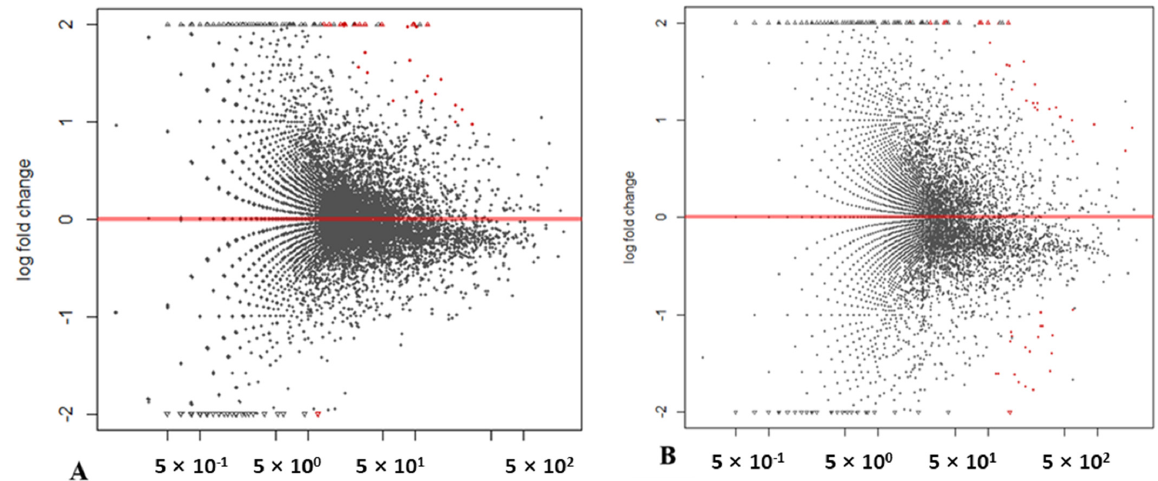
Figure 2. MA-plot from base means ( x -axis; ‘M’) and the average of log fold changes ( y -axis; ‘A’), indicating differentially expressed genes in pea resistant (R) or susceptible (S) to Aphanomyces root rot in DESeq analyses of ( A ) an in silico mix with three replicates in resistant (R) and susceptible (S) bulks, and ( B ) an in silico mix with two replicates in R and S bulks. Red spots indicate genes with P adj < 0.05.